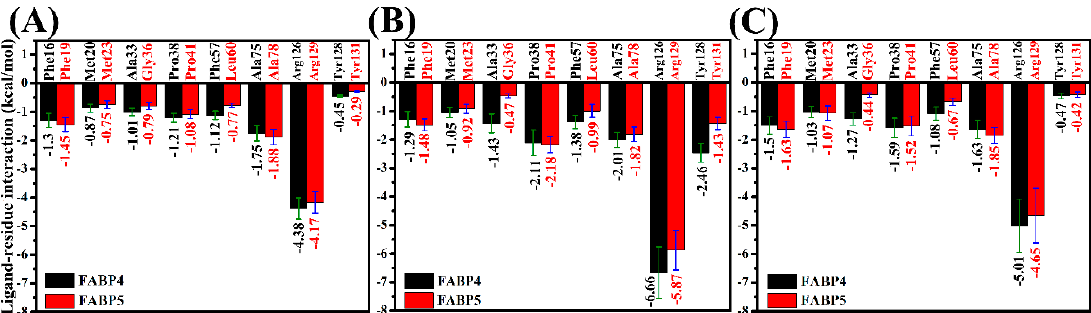
Figure 4. Comparisons between ligand-residue interactions of FABP4 and FABP5: ( A ) 5M7; ( B ) 65X; and ( C ) 65Z.